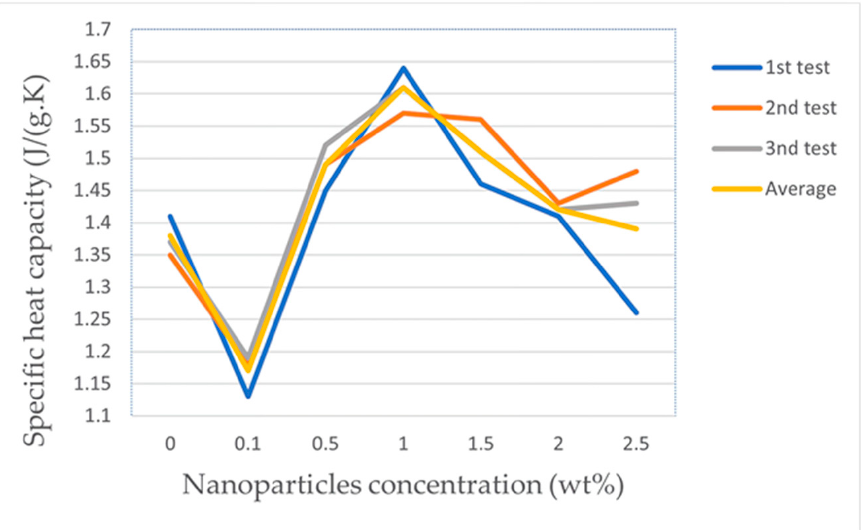
Figure 7. SHC (Specific heat capacity) for molten salt and nanofluids with different GNP concentra- tions. [65].